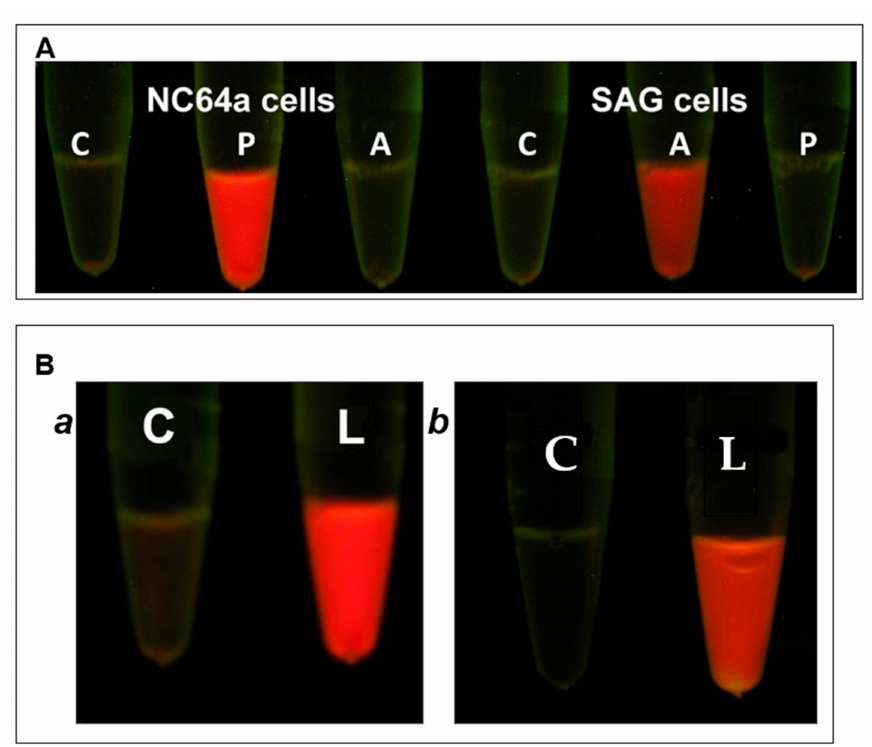
Figure 2. Specificity of the reaction of chlorella cells to virus infection and to virion associated cell wall degrading activity. ( A ). Exposure of chlorella host cells to chloroviruses PBCV-1 and ATCV-1. From left to right: (C) control (intact C. variabilis NC64A cells treated with 1% SDS), (P) C. variabilis NC64A cells plus intact PBCV-1, (A) C. variabilis NC64A cells plus intact ATCV-1 virus, (C) control (intact C. heliozoae SAG cells treated with 1% SDS), (A) C. heliozoae SAG cells plus intact ATCV-1 virus, (P) C. heliozoae SAG cells plus intact PBCV-1 virus. Cells (concentration 2 × 10 7 ) were infected with viruses at a MOI of 5 incubated for 15 min and SDS was added to 1%. (Note: One obtains the same results if one uses Triton X-100 at the same concentration.) Note the specificity of chlorovirus infection. ( B ). Exposure of chlorella host cells to PBCV-1 vLysin: Panel a : C. variabilis NC64A cells, Panel b : C. heliozoae SAG cells. (C) Control (intact cells treated with 1% SDS), (L) cells incubated with PBCV-1 vLysin. Cells (concentration 2 × 10 7 ) were treated with activity equivalent to 5 × 10 10 PFU/mL for 15 min followed by addition of SDS. Note that the PBCV-1 vLysin treatment resulted in the release of chlorophyll from both types of cells. Images were taken under UV light to evaluate the autofluorescence of chlorophyll